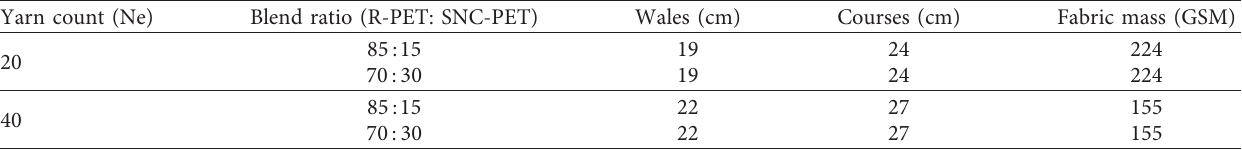
Table 3: Details of knitted fabric parameters.